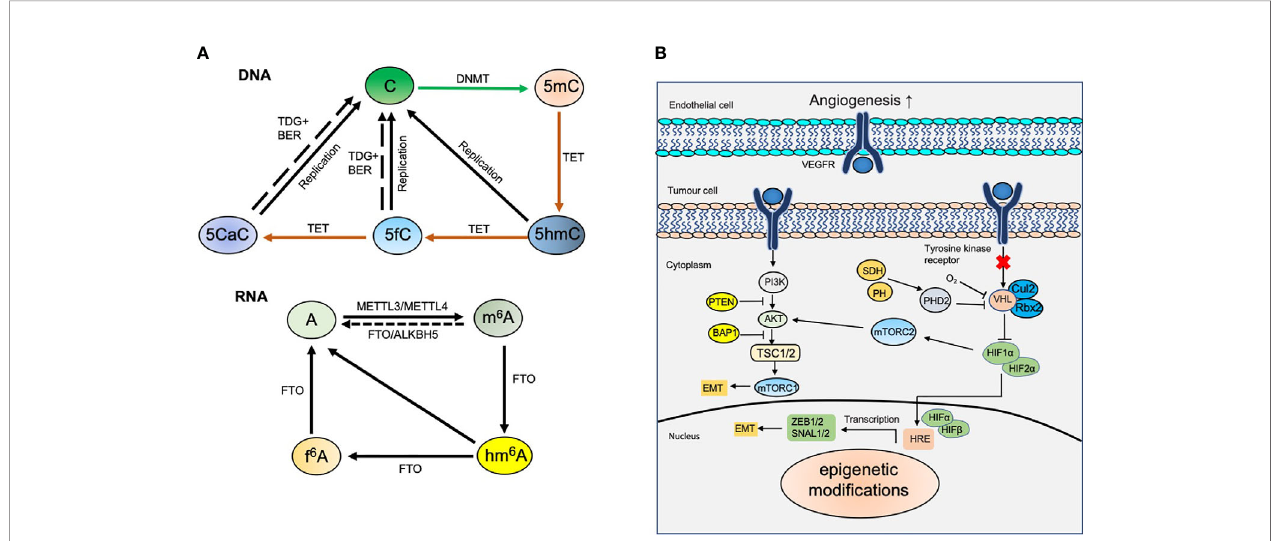
FIGURE 1 | Dynamic modi fi cations in kidney cancer. (A) Dynamic DNA and RNA modi fi cations. DNA methyltransferases (DNMTs) including de novo methyltransferases DNMT3A, DNMT3B and maintenance methyltransferase DNMT1 convert unmodi fi ed cytosine (C) to 5 ‑ methylcytosine (5mC). 5mC can be converted to 5 ‑ hydroxymethylcytosine (5hmC) by ten-eleven translocation (TET) proteins ‑ mediated oxidation. TET proteins also catalyze the oxidation of 5hmC to 5 ‑ formylcytosine (5fC) and 5 ‑ carboxylcytosine (5caC). 5fC and 5caC can be further excised by thymine DNA glycosylase (TDG) coupled with base excision repair (BER) to generate unmodi fi ed cytosine. N 6 -methyladenosine (m 6 A) in mRNA is installed by methyltransferase-like protein 3 (METTL3) and METTL14, and erased by fat mass and obesity-associated protein (FTO) and a ‑ ketoglutarate-dependent dioxygenase alkB homologue 5 (ALKBH5). m 6 A can be further oxidized to N 6 - hydroxymethyladenosine (hm 6 A) and N 6 -formyladenosine (f 6 A) sequentially by FTO. (B) Epigenetic modi fi cations involve in kidney cancer. Epigenetic modi fi cations regulate diverse signaling pathways including HIF and PI3K-AKT and involve in kidney